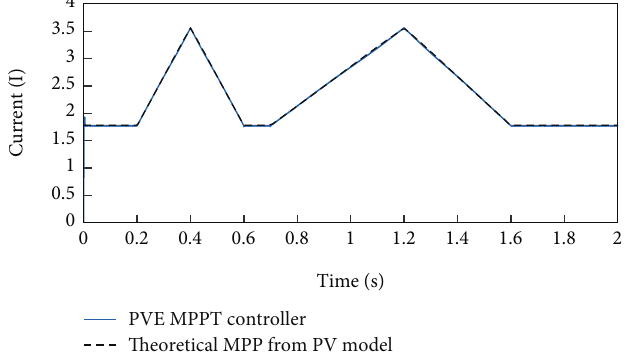
Figure 28: Current of the PVE system with MPPT control under the EN 50530 test.